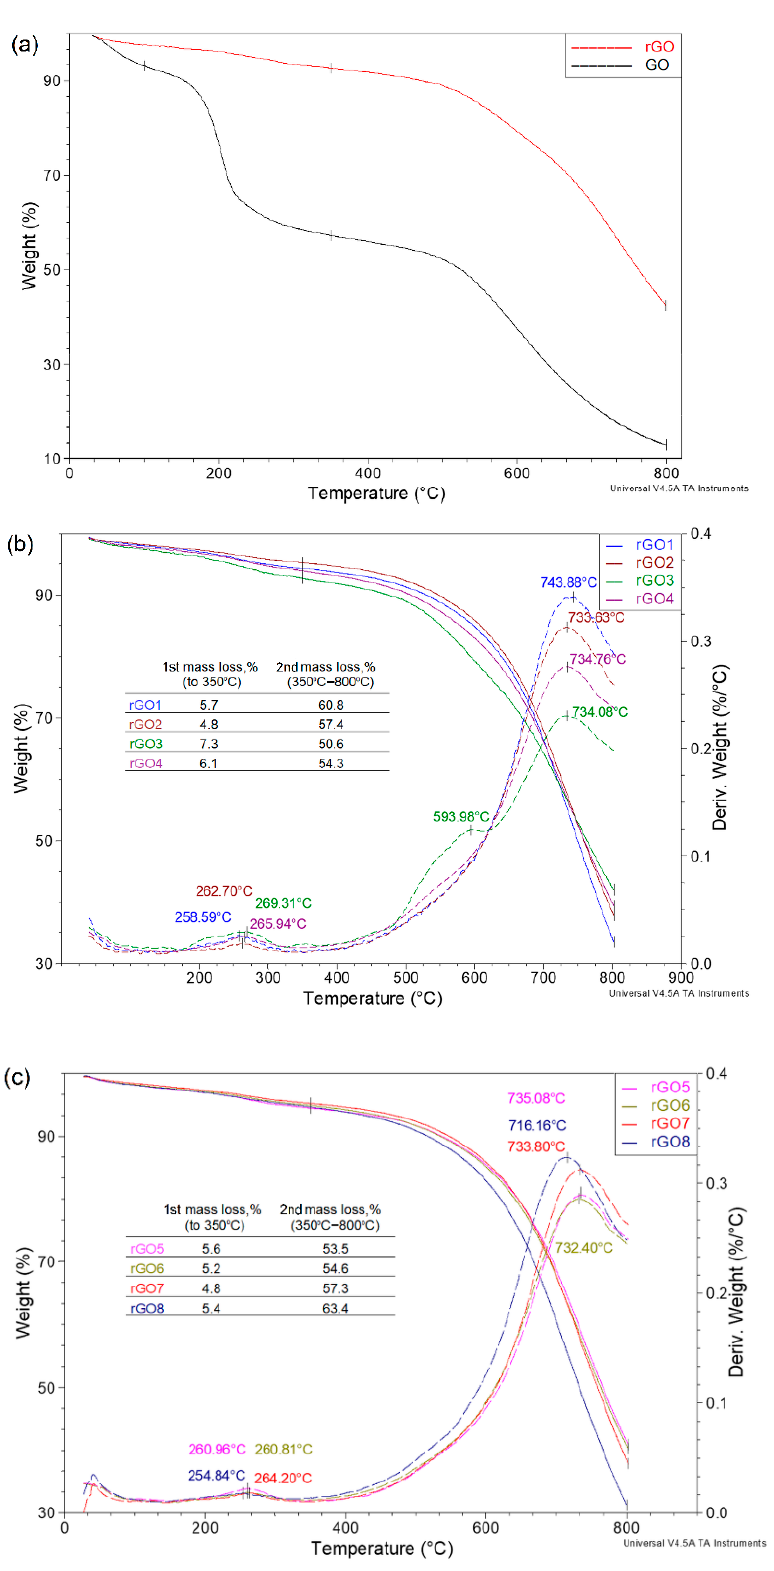
Figure 8. ( a ) TGA curves for graphene oxide and reduced graphene oxide; ( b ) TGA curves for rGO1–4; ( c ) TGA curves for rGO5–8.